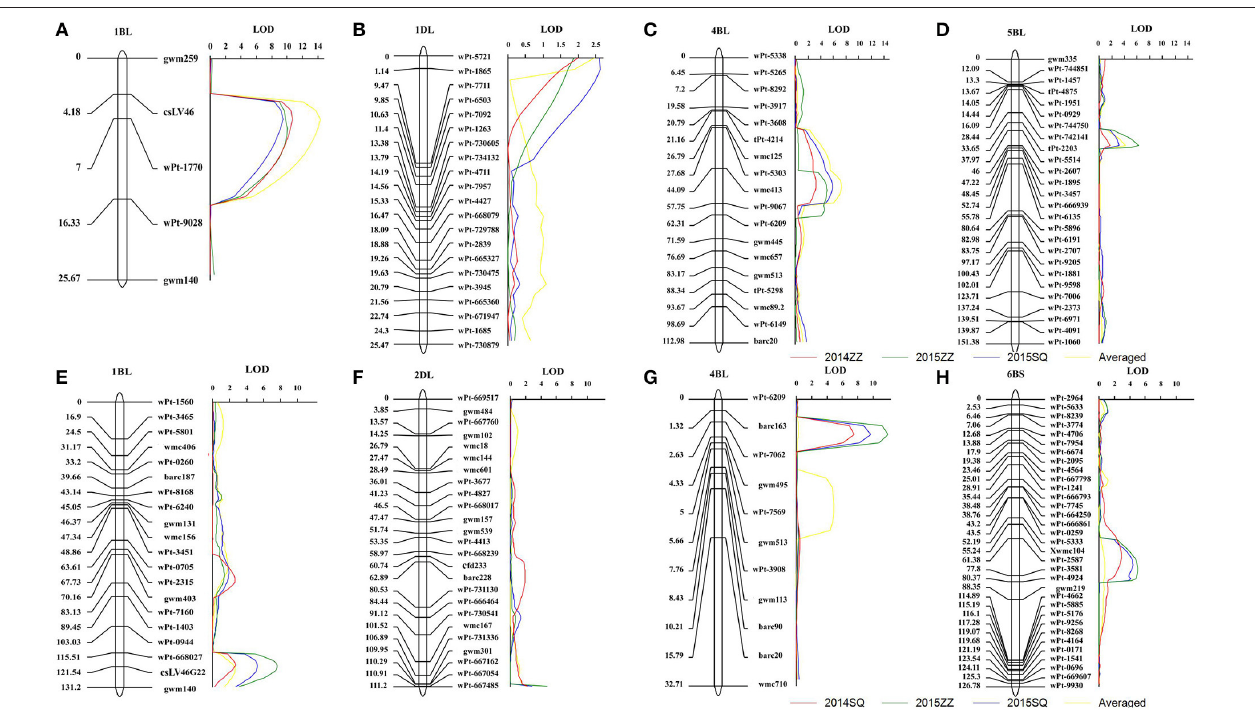
Frontiers in Plant Science |